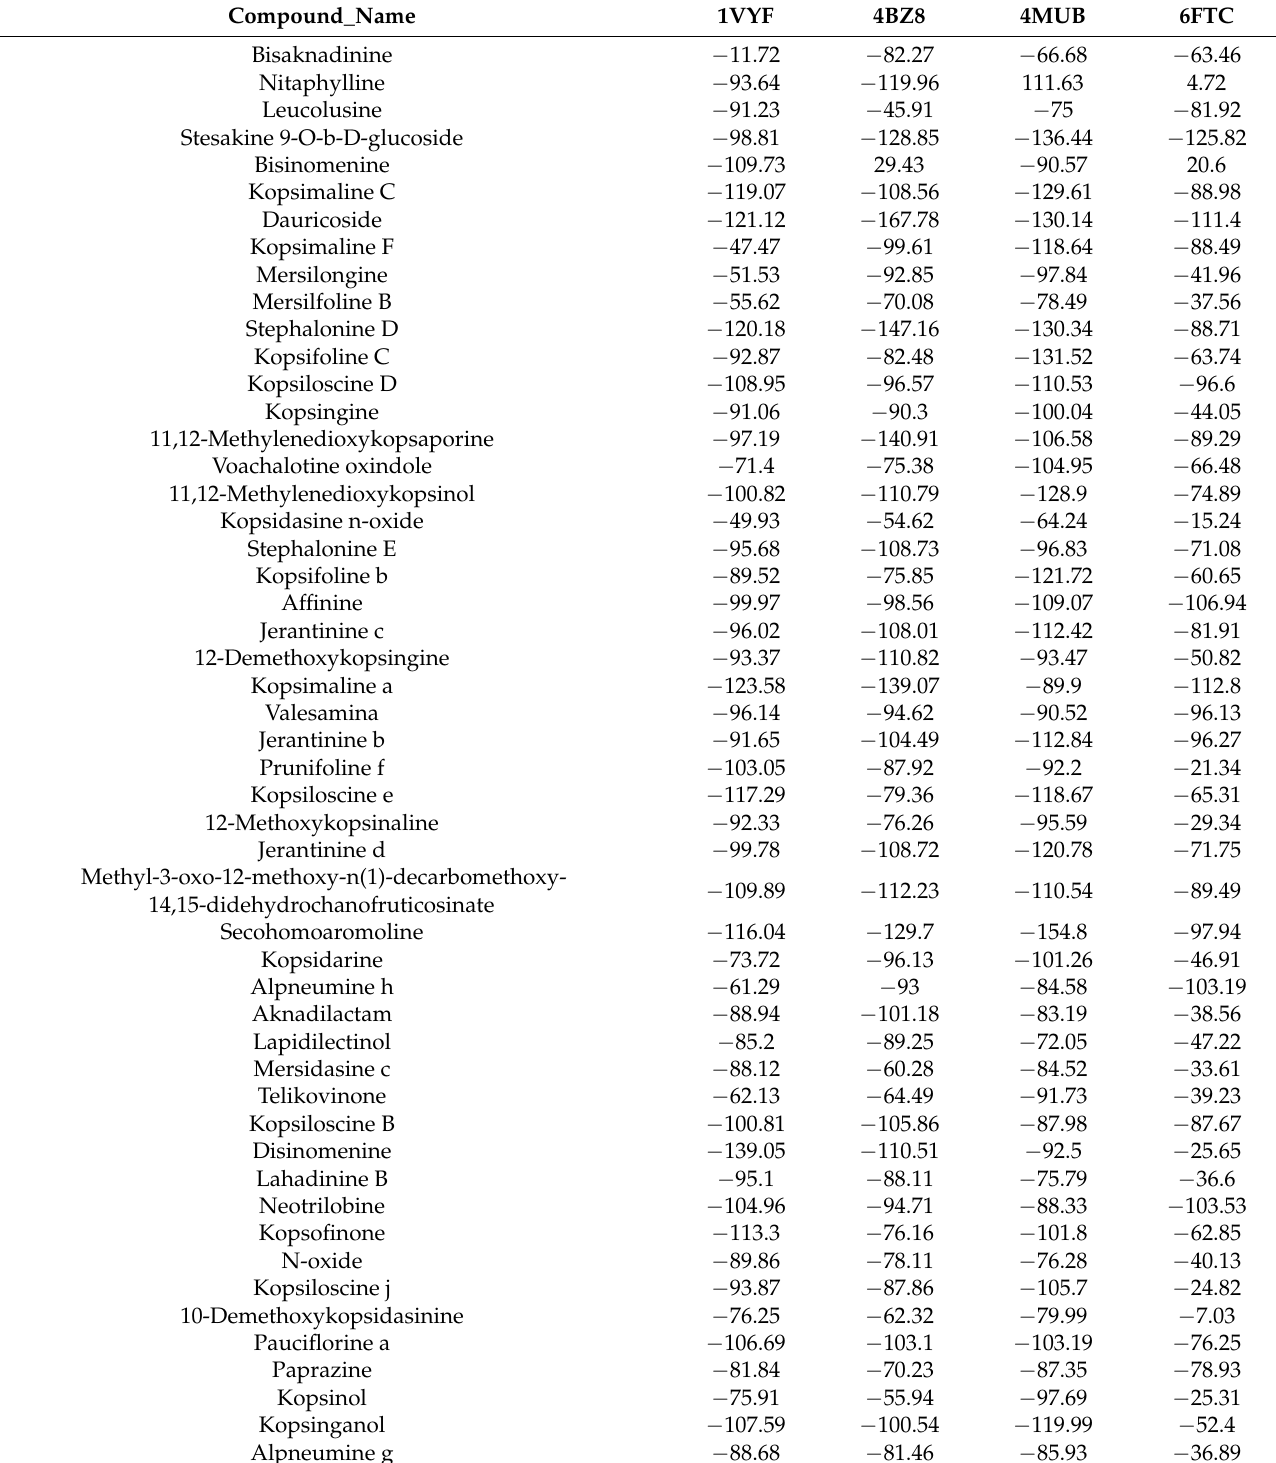
Table A1. Molecular docking results of 61 alkaloids in four S. mansoni proteins. Energy values were quantified in kilocalories per